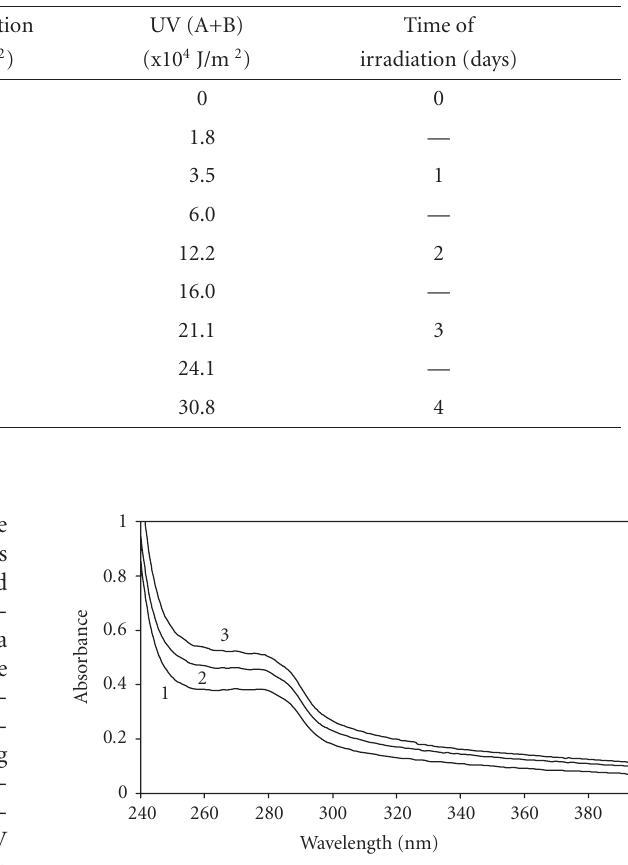
Figure 1: UV-VIS spectra of collagen before (curve 1) and after 2 days (curve 2) and 5 days (curve 3) of solar irradiation (key to time and dose of solar radiation in Table